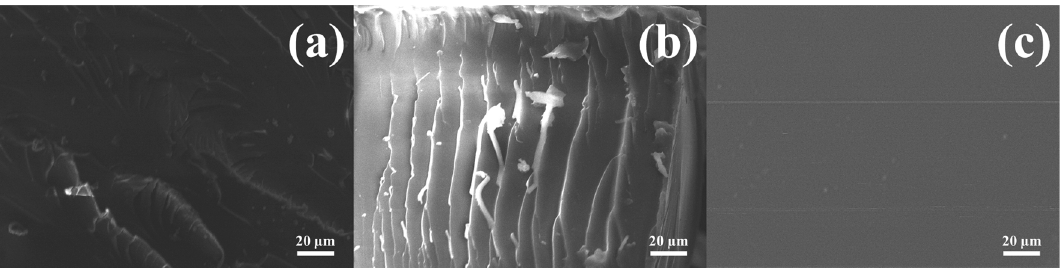
Figure 8. Scanning electron microscopy (SEM) images on the impact fractured surface of cured epoxy/polyimide composites: ( a ) EP, ( b ) EPI-5, and ( c ) EPI-5-10.